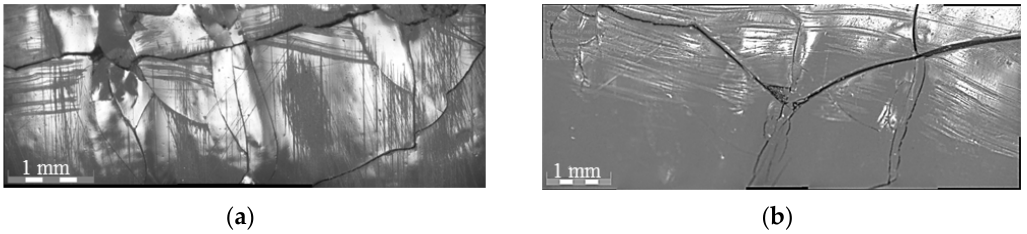
Figure 5. Scratch test on PDMS: Images by opto-microscopy after (APPT) with polyurethane ( a ) PDMS + APPT/PU and epoxy ( b ) PDMS + APPT/EP.